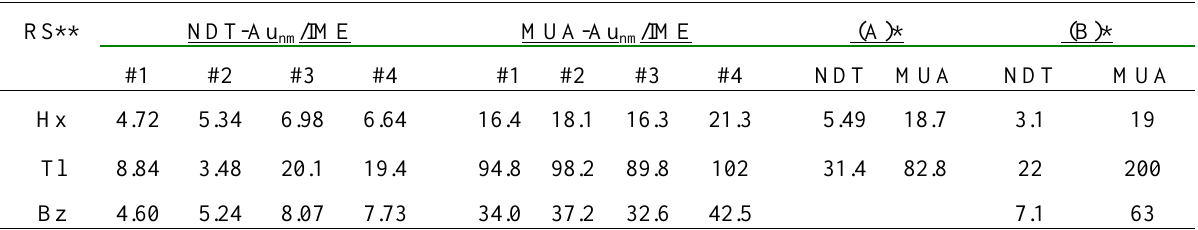
Table 3. Comparison of response sensitivities to hexane, toluene and benzene at NDT-Au MUA-Au films on different nm